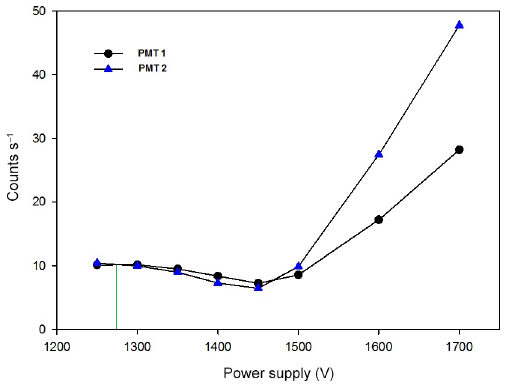
Figure 2. Counting rate vs. voltage for PMT type 53AVP (Philips). Note the plateau below 1500V and the crossing point of both curves in 1270V (bias voltage